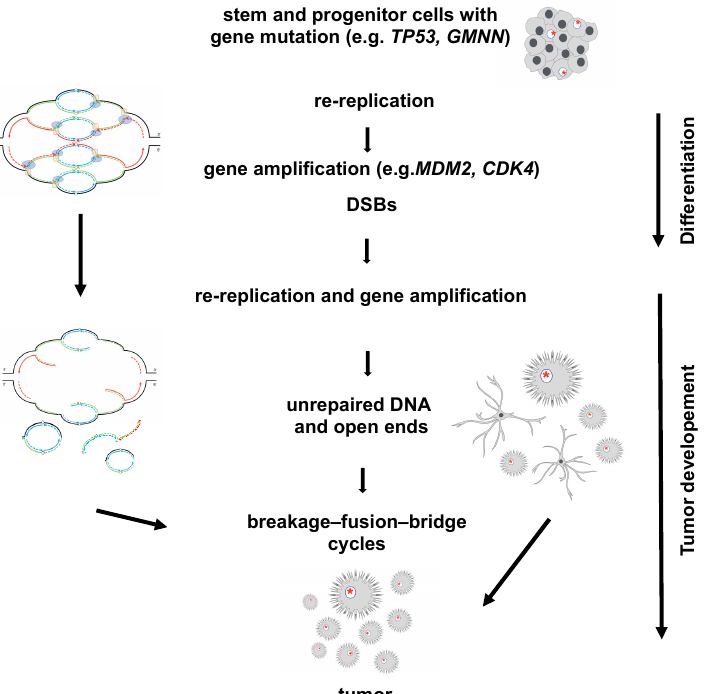
9 of 12 Figure 2. Transient re-replication and gene amplification during differentiation. The processes of re-